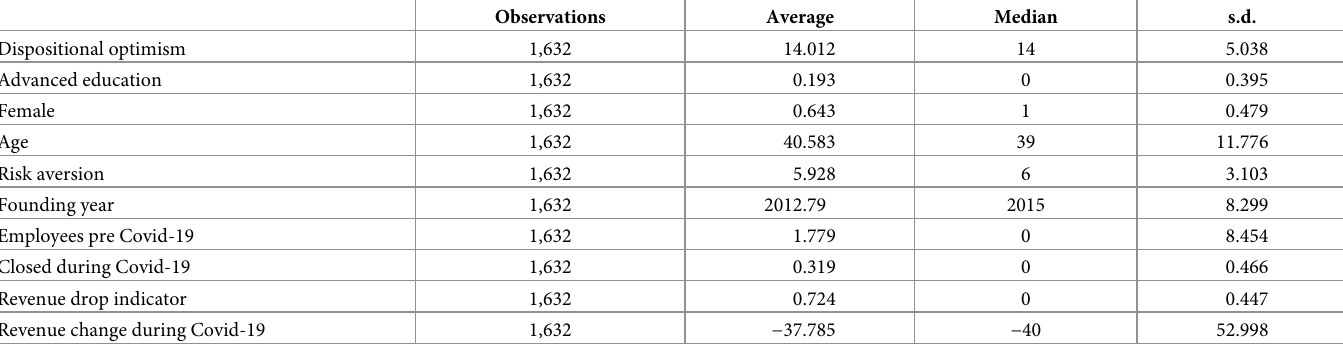
Table 1. Summary